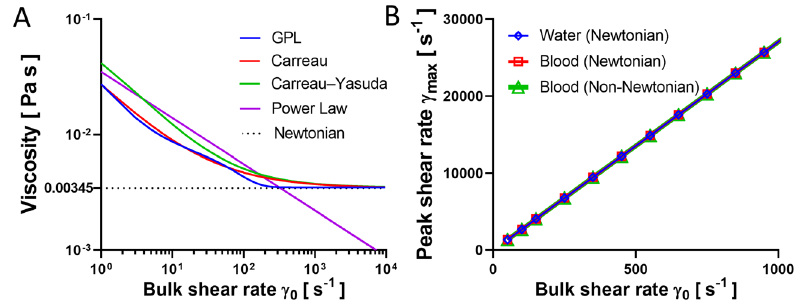
Figure 5. Benchmarks of viscosity models and flow medium effects. ( A ) Relationship between bulk shear rate γ 0 and viscosity for the different viscosity models. Note that the viscosity for most models first decreases then approaches to constant 0.00345 Pa s at γ 0 > 500 s −1 . ( B ) Relationship between peak shear rate and viscosity for water (blue), Newtonian blood (red) and non-Newtonian blood (green). The peak shear rates γ max are indifferent for all